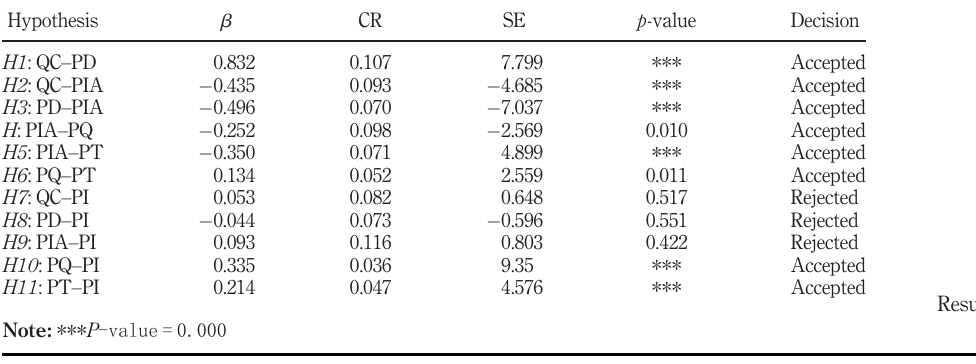
Table 3. Results of path